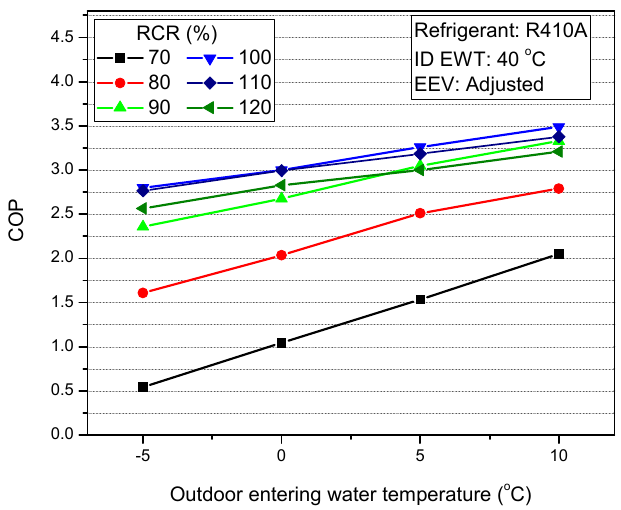
Figure 19. COP with variation of T OD in heating mode.